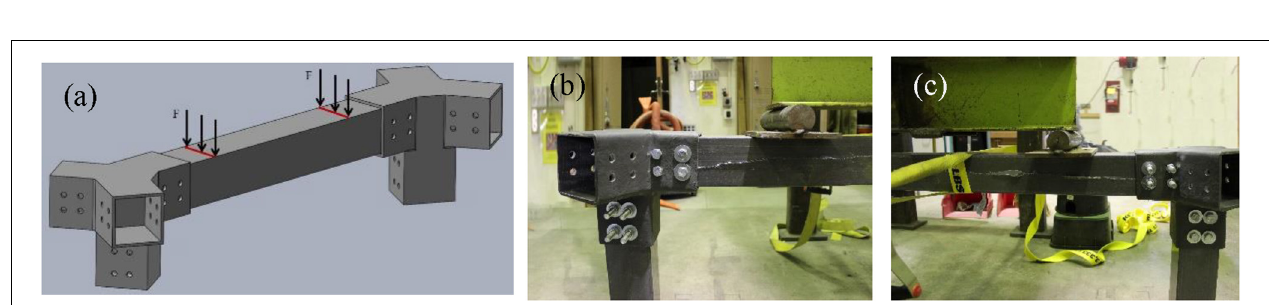
FIGURE 3 | Compression test with an FRP horizontal beam supported at its two ends. (a) The schematic view of the experimental setup, (b) front, and (c) back view of the propagated cracks.